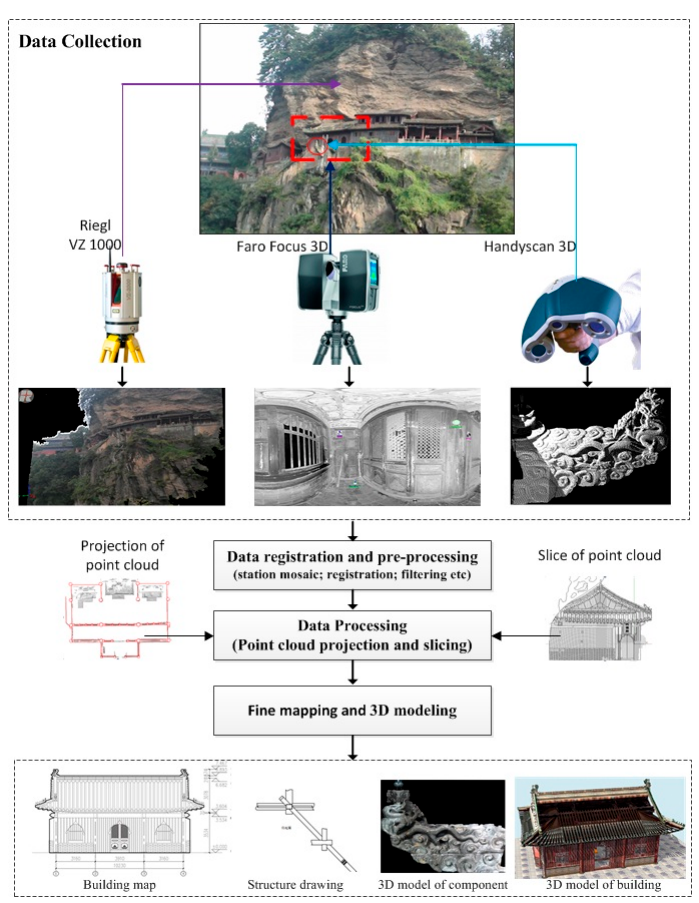
Figure 3. Proposed idea for the fine mapping and 3D documentation of Liangyi Temple.